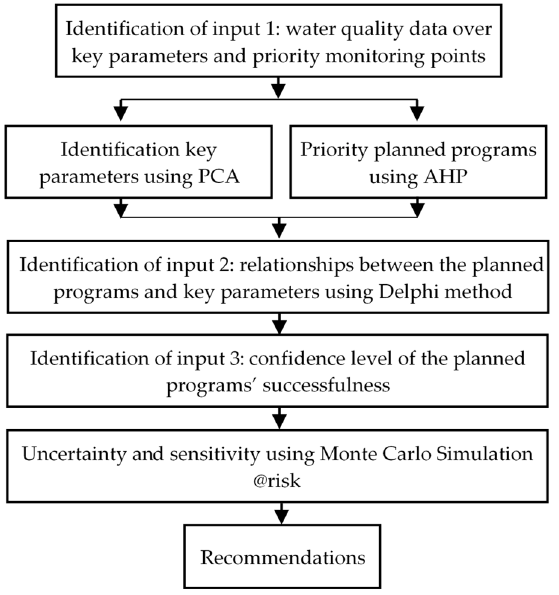
Figure 2. Steps used for uncertainty and sensitivity analysis in the study.